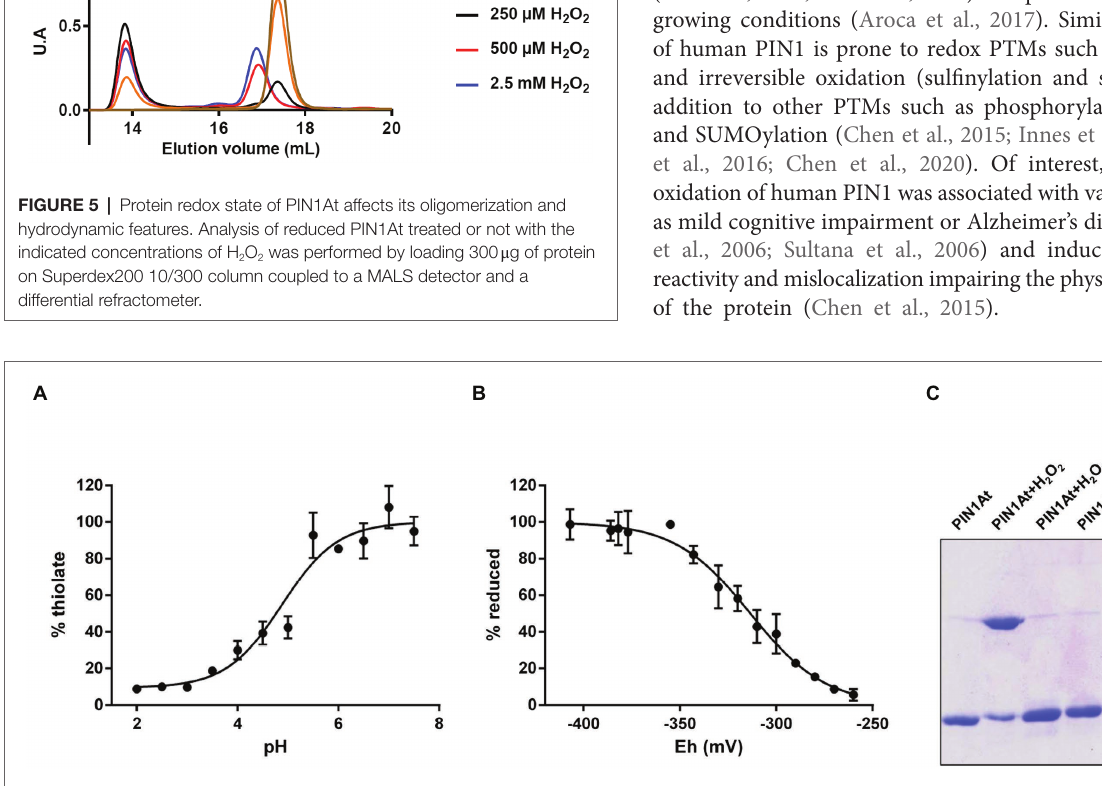
FIGURE 6 | Redox properties of PIN1At. (A) The p K a values of sulfhydryl group Cys69 were determined by incubating 10 μ M of reduced PIN1At in buffers ranging from pH 2.0 to 7.5 in the presence of 200 μ M fluorescein-IAM which reacts with thiolates. The resulting fluorescence emission was expressed as % of maximal fluorescence as a function of the pH value of the solution. The obtained p K a value is the mean ± SD of three separate experiments. (B) The titration of disulfide- bridged PIN1At dimer (10 μ M) was carried out using a total DTT concentration of 2 mM for 2 h at pH 7.0. Free thiol groups were labeled by mBBr and the resulting fluorescence emission was expressed as % of reduced protein and fitted to the redox potential of the solution. The obtained E m value is the mean ± SD of three independent replicates. (C) Reduction of the H 2 O 2 -mediated disulfide-bridged PIN1At dimer. Reduced PIN1At was treated with 500 μ M H 2 O 2 and incubated or not for 30 min in the presence of TRX system composed of 200 μ M NADPH, 100 nM Arabidopsis NTRB, and 1 μ M poplar TRXh1 or h3. The reaction was stopped after 30 min and protein mixtures separated on 15% SDS-PAGE in non-reducing conditions. The gel is representative of three